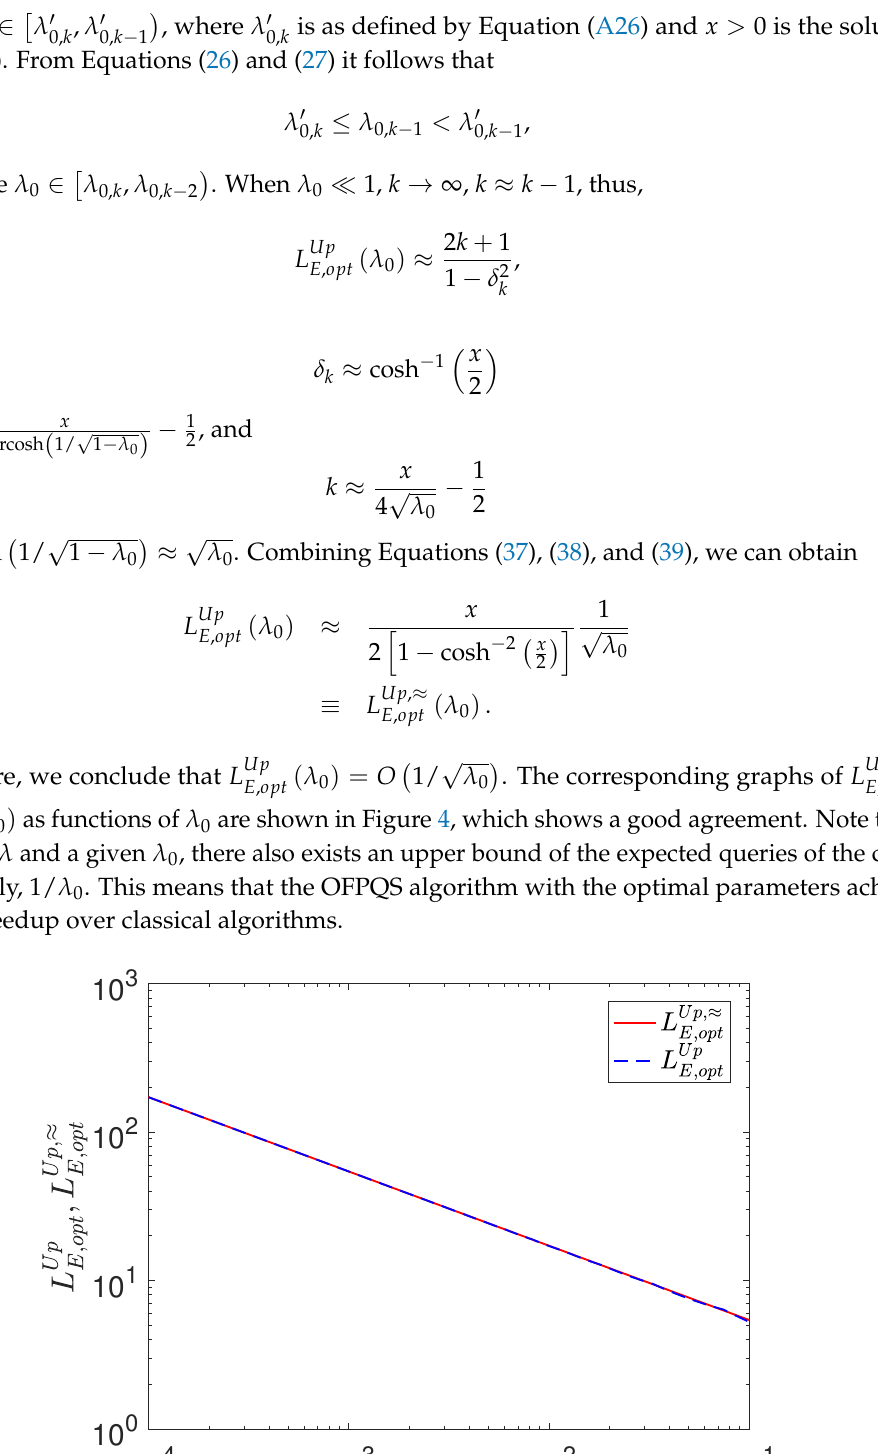
≈ ( λ ) as functions of the lower bound λ 0 E , opt